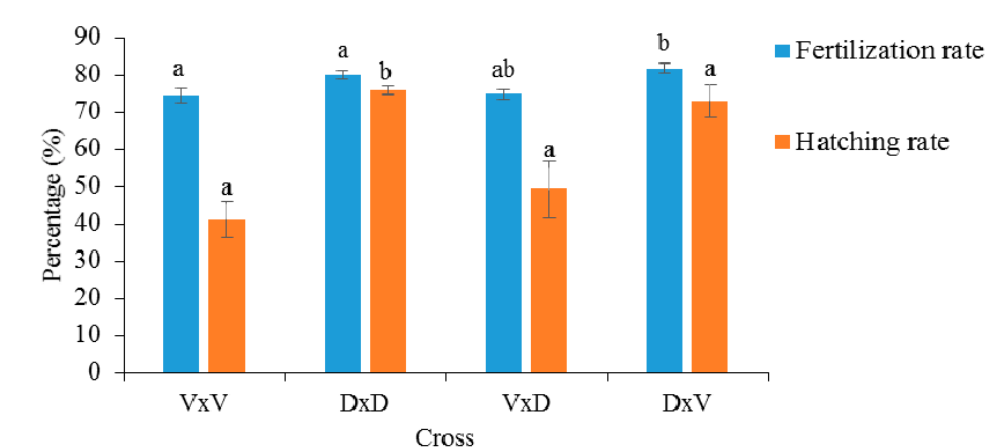
Figure 3. Fertilization and hatching rates of the analyzed hybrid and purebred Volga and Danube sterlet. Columns with the same superscript do not differ significantly at p < 0.05.